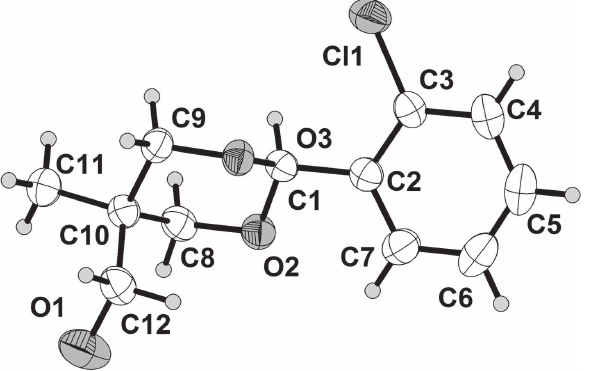
Table 1: Data collection and